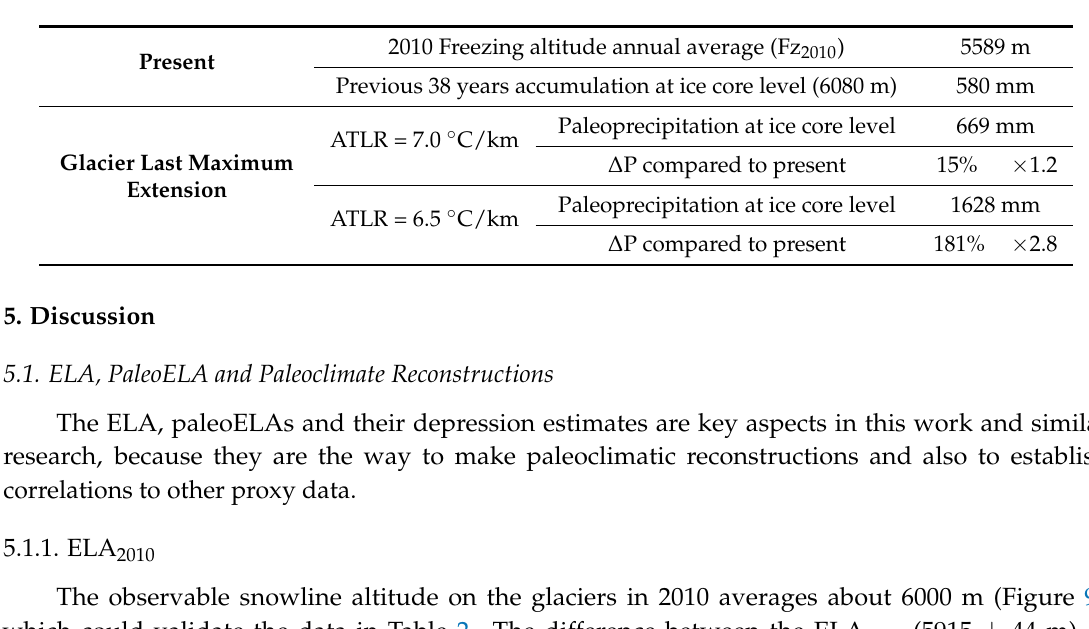
Table 6. Paleoprecipitation at the time of maximum glacial extension. Fz 2010 was deducted from the data 1 January 2010–31 December 2010 recorded by CRYOPERU thermometers. Ice core data from Herreros et al.